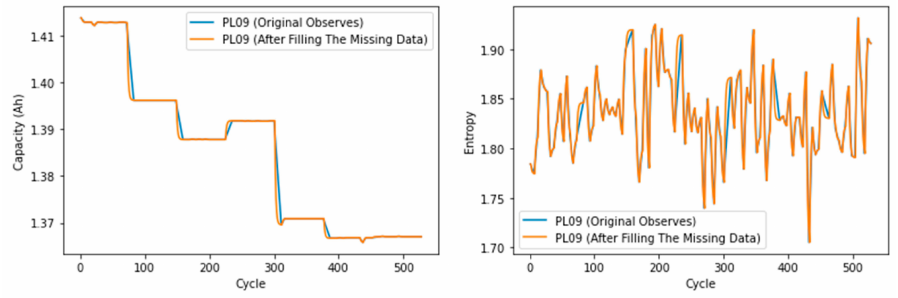
Figure 5. Capacity vs. Cycle ( left ) and Entropy vs. Cycle ( right ) for